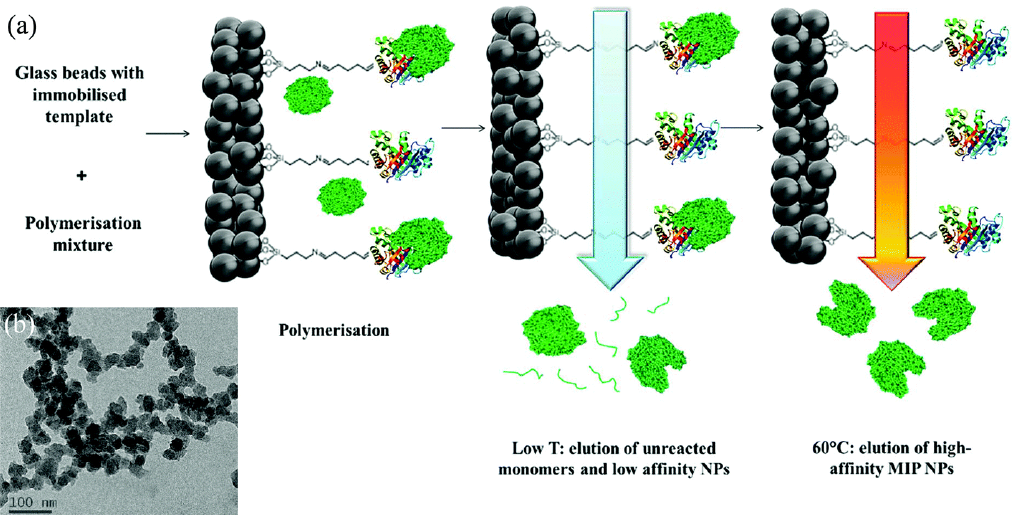
Figure 1. ( a ) Scheme of the solid-phase synthesis of nanoMIPs. In this example, a protein is shown as the template molecule. ( b ) Representative TEM of biotin MIPs. Reproduced from [31]—Published by The Royal Society of Chemistry.